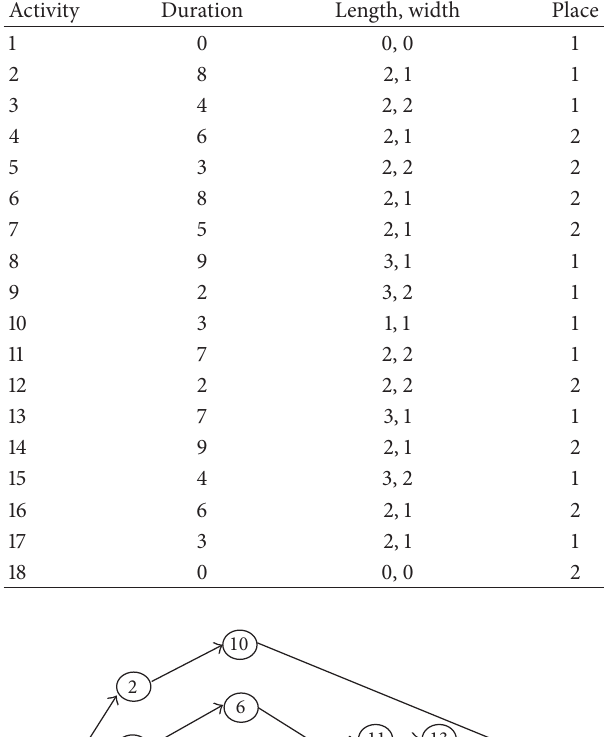
Table 1: The parameters of activities.